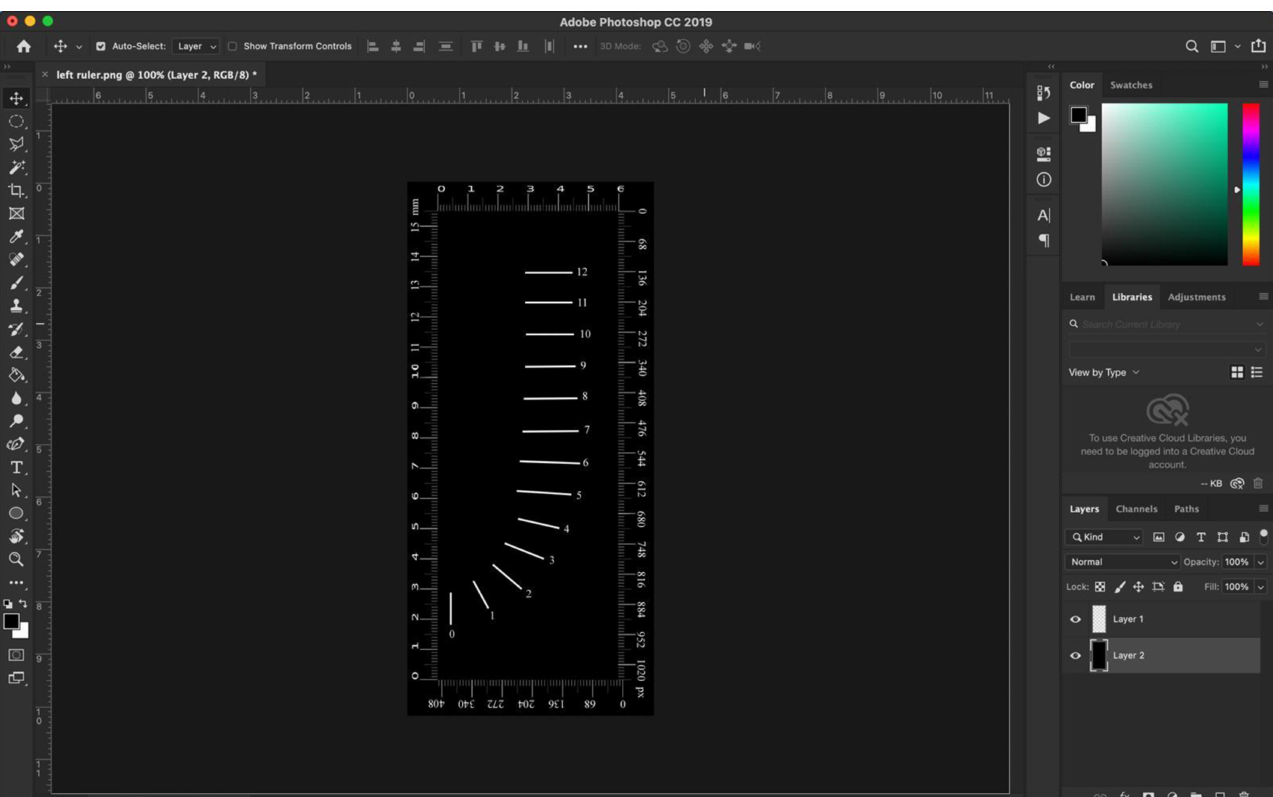
Figure 1. Measuring ruler for the thirteen evaluated levels in mm and pixels (Adobe Photoshop CC-License Type: Subscription, Serial number: